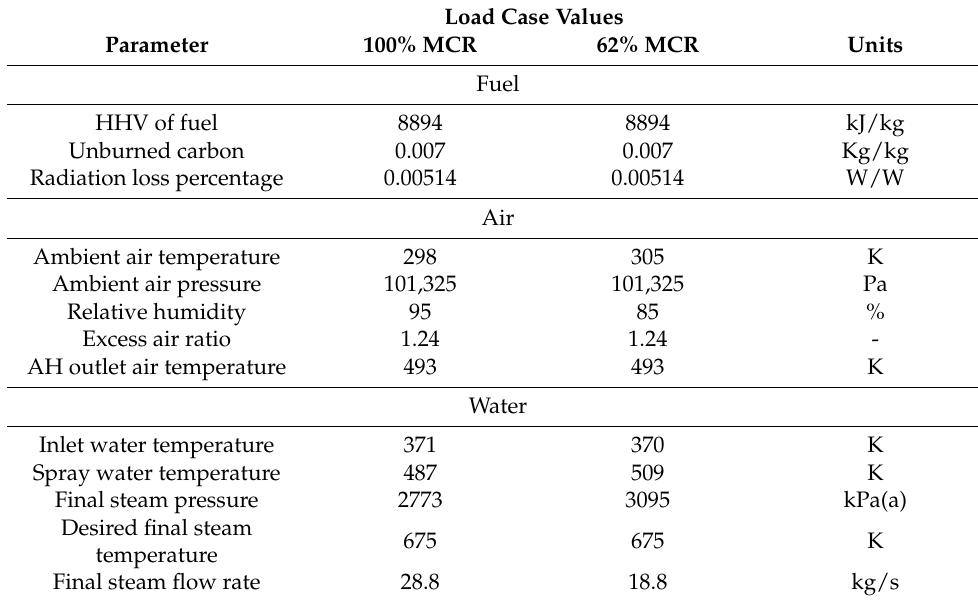
Table 6. Biomass fuel composition (from actual fuel analysis).